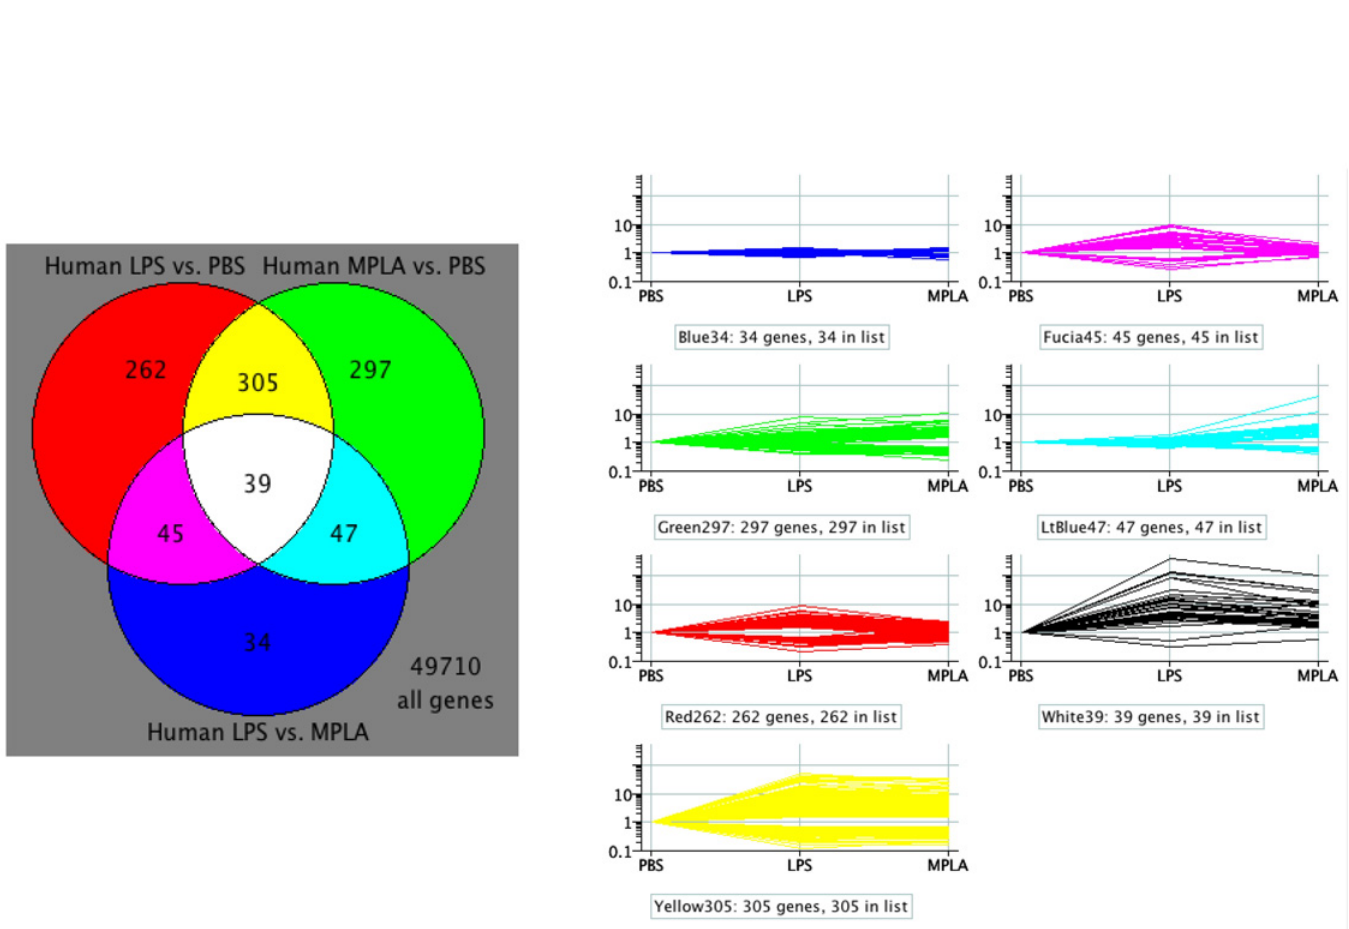
Fig 5. Differentially expressed human genes in at least one of three comparisons ( > 1.5-fold, paired t-test p-values < 0.05, 1,029 probes) are displayed as normalized to the PBS sample within each individual. Line graph colors correspond to the colors in the Venn diagram (white = black).